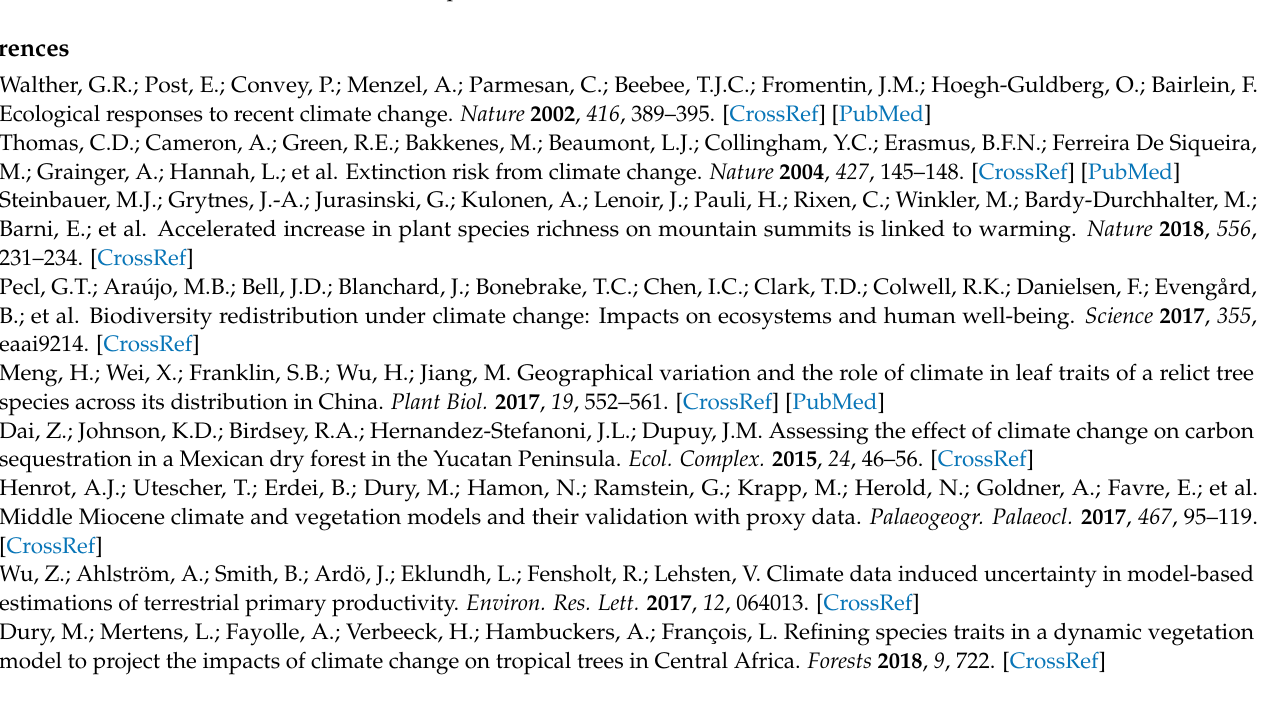
Table S4: Linear models of three traits (specific leaf area, leaf C:N and sapwood C:N) as a function of climate factors (means over 2014, 2015 and 2016 of precipitation: prc, of daily temperature range: dte, of temperature: tem, of sunshine hours: shr, wind speed: wnd, of potential evapotranspiration: pet, of relative humidity: rhu) effects (linear effects and pairwise interactions). Best models (with max-imum 5 terms for sample sizes = 16) after exhaustive searches and selections on the basis of AIC and F tests; Table S5: Estimations of mean biomass for 2013 to 2017 (kg C/sq. m) and of net primary productivity (NPP) for years 2012 to 2016 (g C/sq. m/yr); Videos S1–S3: Simulated net primary productivity over the study area between 1900 and 2016 with PFT traits , Field mean traits or Computed traits ; Videos S4–S6: Simulated biomass over the study area between 1900 and 2016 with PFT traits , Field mean traits or Computed traits